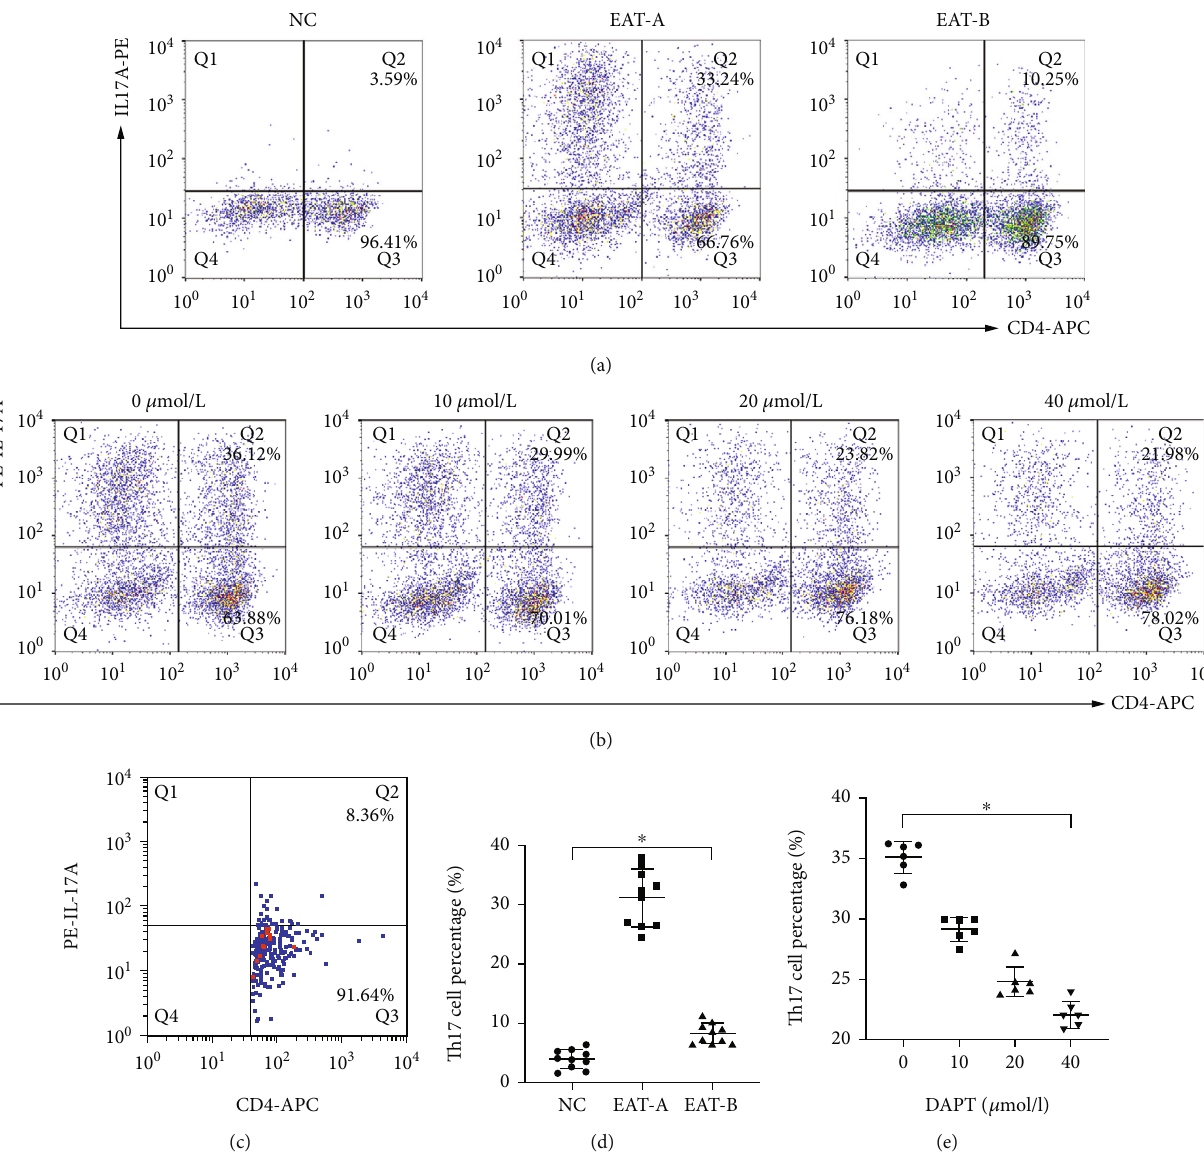
Figure 5: Flow cytometric analyses of Th17 cells in SMCs and TMCs. (a) Representative fl ow cytometry results of Th17 cells in SMCs in the three groups. (b) Representative fl ow cytometry results of Th17 cells in SMCs from EAT-A mice treated with di ff erent concentrations of DAPT in vitro. (c) Representative fl ow cytometry analyses of Th17 cells in TMCs from EAT-A mouse thyroids. (d) Summary of Th17 cell proportions. There were signi fi cant di ff erences of Th17 cells in SMCs among the three groups (Welch F = 140 : 301 , ∗ P < 0 : 001 , Welch ’ s ANOVA). Additionally, Th17 cell percentages in EAT-A mice were signi fi cantly higher compared to those in NC mice ( 31 : 16 ± 4 : 79 % vs. 3 : 99 ± 1 : 59 % , P < 0 : 001 , Tamhane ’ s T2 test). In EAT-B mice, DAPT treatment via intraperitoneal injection signi fi cantly decreased the percentage of Th17 cells ( 7 : 76 ± 1 : 58 % ) compared to EAT-A mice ( P < 0 : 001 , Tamhane ’ s T2 test). (e). Summary of Th17 cell percentages in four groups with di ff erent DAPT concentrations in vitro. Analyses revealed that Th17 cell percentages decreased in a concentration- dependent manner ( F = 144 : 293 , ∗ P < 0 : 001 , one-way